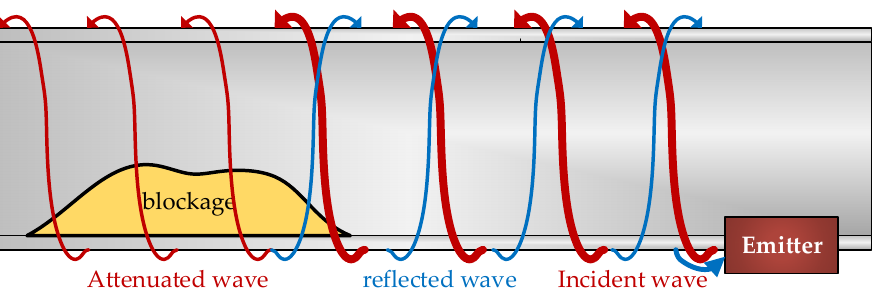
Figure 8. Blockage detection. The torsional wave travels along the pipe until it finds the blockage, which attenuates the propagation and gives rise to a reflected wave.